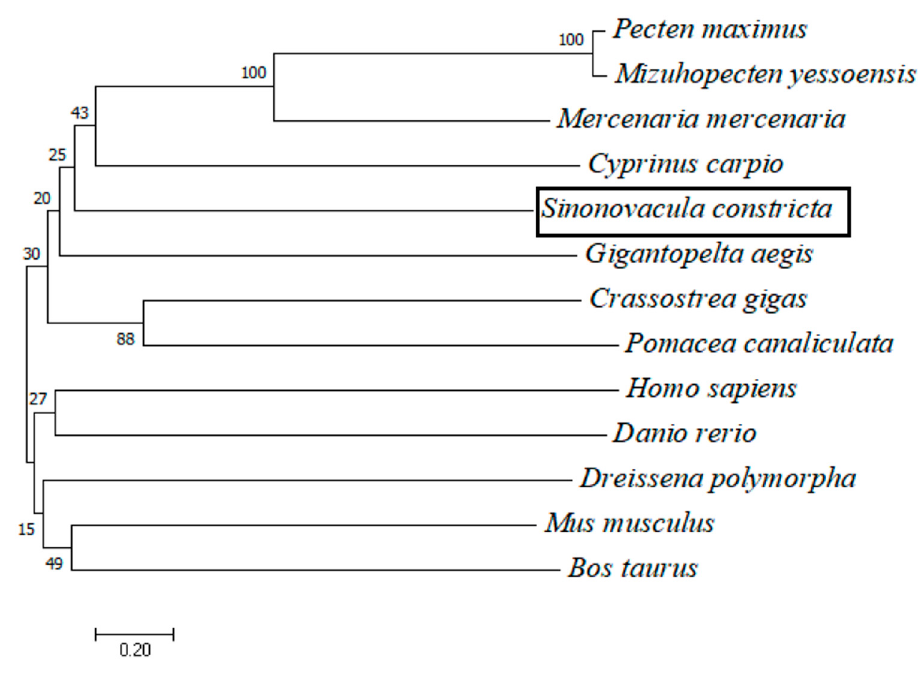
Figure 2. NJ phylogenetic tree of amino acid sequences from cGMPase in different species. Accession